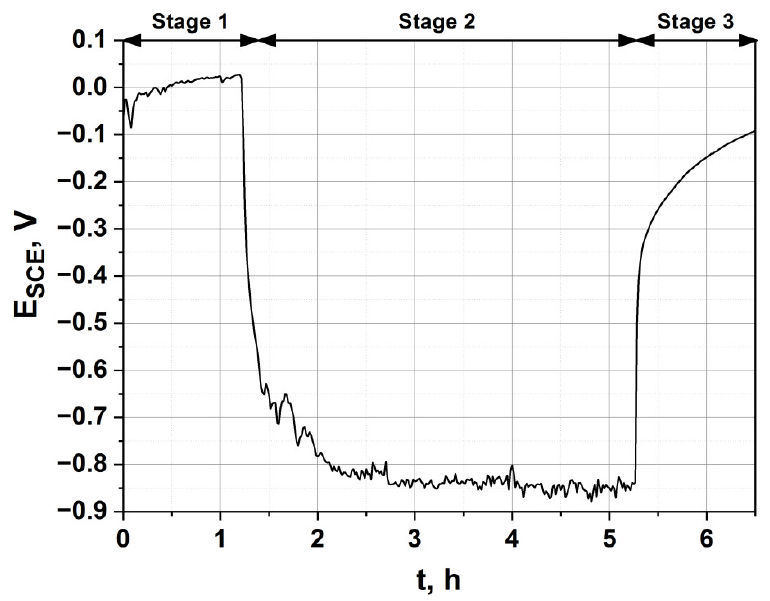
Figure 11. Change in the corrosion potential during the tribological test in Ringer’s solution at 25 °C of the alloy hardened at 700 °C.